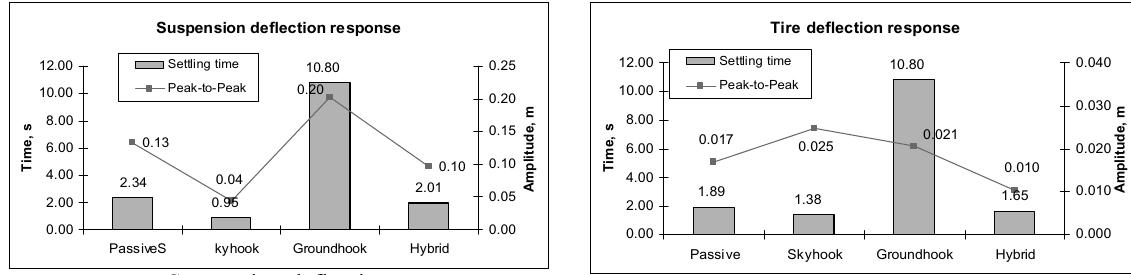
Fig. 7. Summary of results for suspension and tire deflections response.